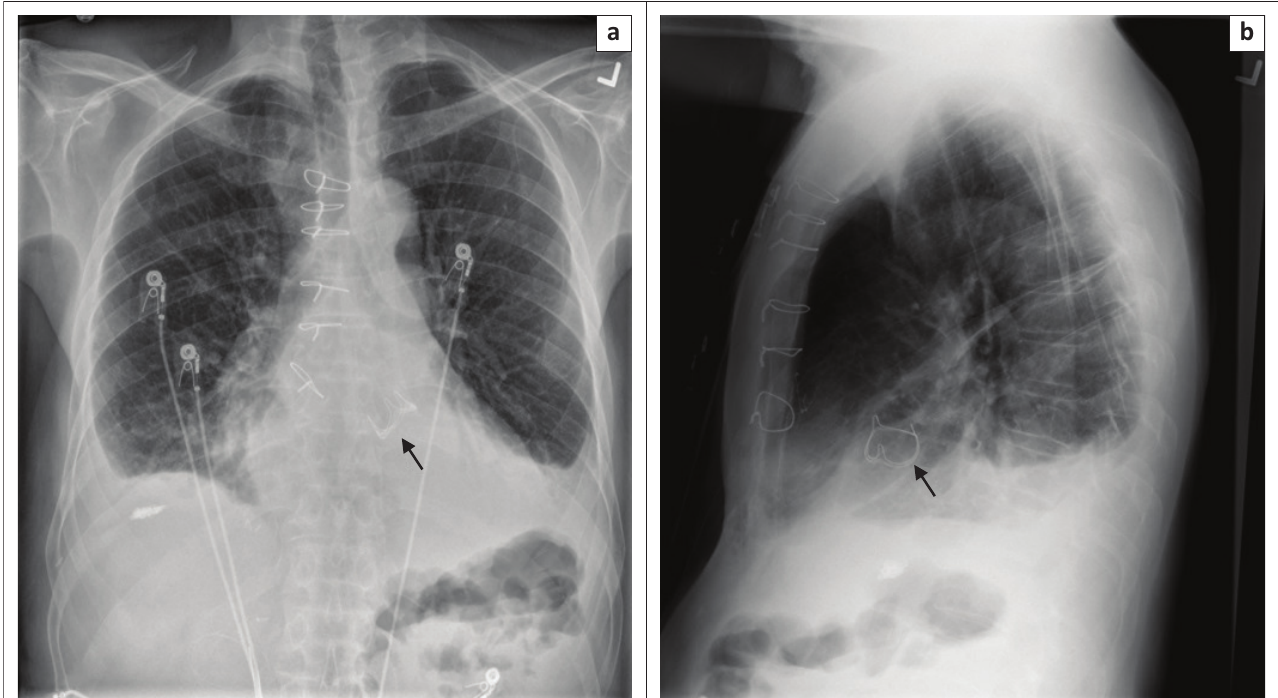
FIGURE 16: Frontal (a) and lateral (b) chest radiographs showing an aortic valve (perimount magna ease tissue valve) replacement (arrow) in a 76-year-old male patient with severe aortic stenosis.